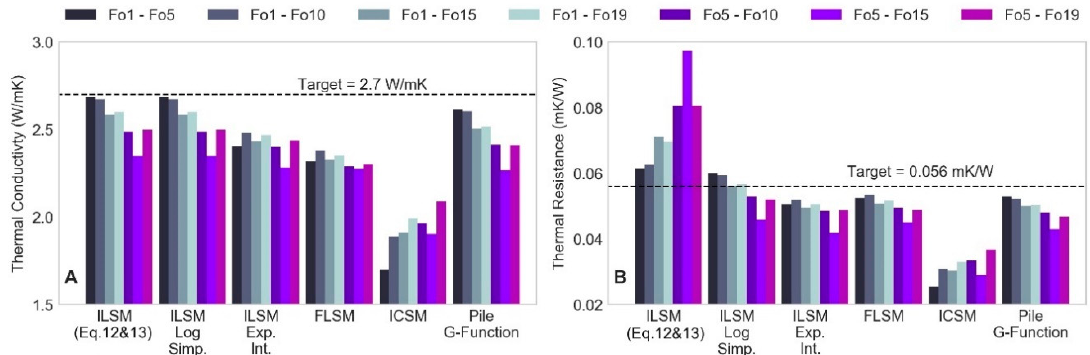
Figure 8. Comparison between analytical models results for ( A ) thermal conductivity and ( B ) pile thermal resistance over seven different fitting regions bounded by the Fourier times shown.